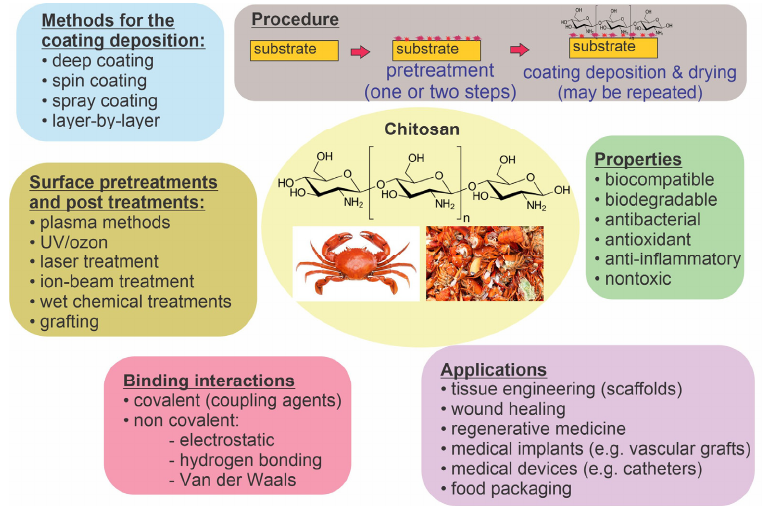
Figure 1. Chitosan’s characteristics, possible applications, and methods of coating preparation.